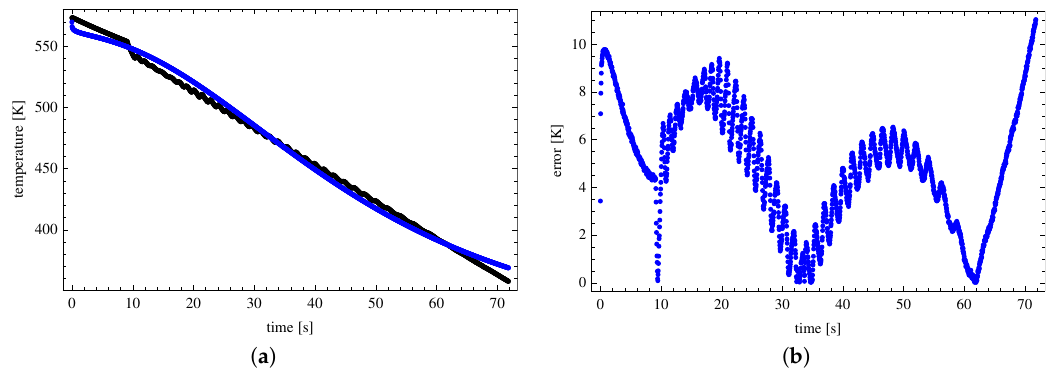
Figure 2. ( a ) Measurements of the temperature (black line) and reconstructed temperature (blue line); and ( b ) distribution of errors for this reconstruction (100 × 1995) .